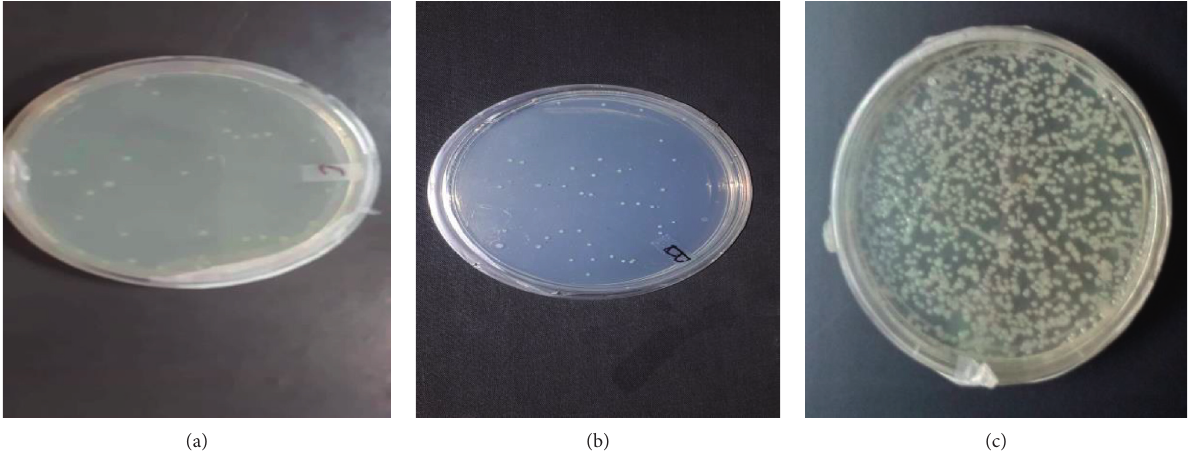
Figure 12: Bacterial growth and inhabitation.